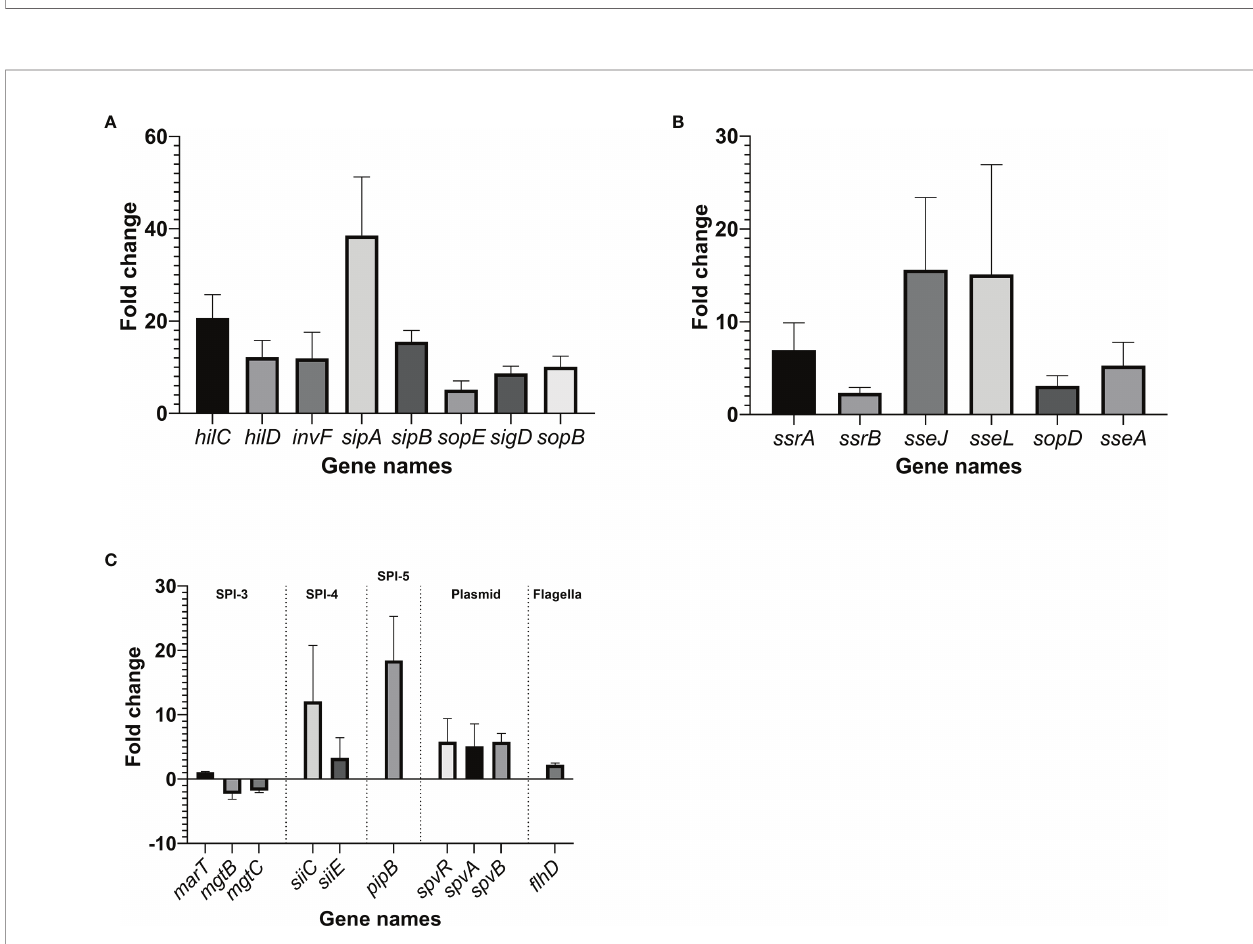
FIGURE 8 | Changes in the transcription of virulence genes within Salmonella pathogenicity island (SPI)-1 (A) , SPI-2 (B) and other virulence components (C) , when the pathogen was grown in yolk compared to its growth in tryptic soy broth. The fold change was calculated through DD Ct method using gapA , a housekeeping gene, as a reference. Error bars represent standard deviation of three independent